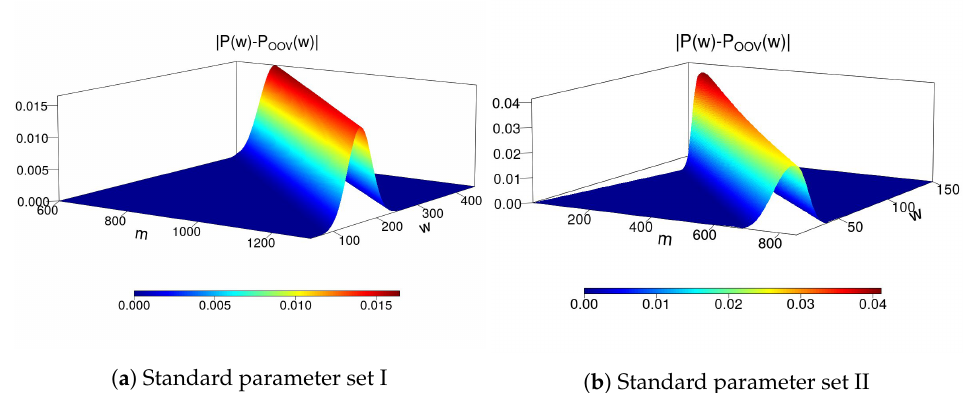
Figure 7. Theoretically, the approximation error decreases as m increases by CLT (note the transition in color of the error peak). In the OOV attack, m = 1164 or m = 441, for standard parameter sets I or II, respectively.